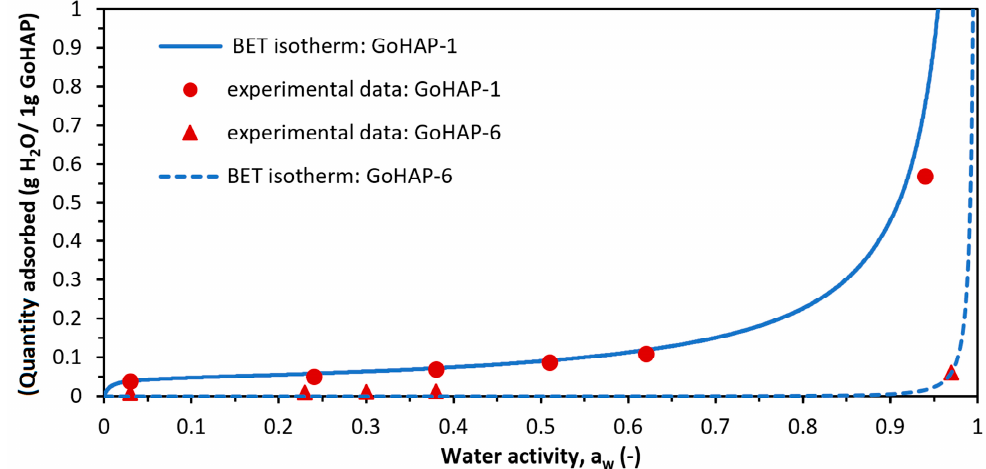
Figure 8. Brunauer–Emmett–Teller (BET) isotherm determined for water adsorption on the surface of GoHAP-1 (10 nm) and GoHAP-6 (40 nm). Table 3. Parameters of BET isotherm of water adsorption on the surface of GoHAP-1 (10 nm) and GoHAP-6 (40 nm). The volume of the monolayer (a m (g H 2 O/ g GoHAP)); the adsorption equilibrium constant (C); standard deviation (S); Fisher Test (F-test).